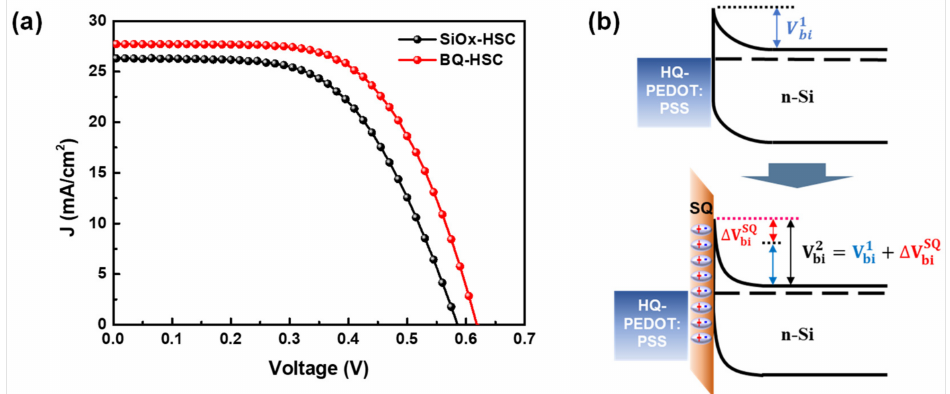
Figure 11. ( a ) Current density vs. voltage curves of SiO x -HSC and BQ-HSC measured under 100 mW/cm 2 illumination (AM1.5) and ( b ) effect of interface dipole formation with BQ passivation of the Si surface. Table 3. Photovoltaic parameters of SiO x -HSC and BQ-HCS. J sc Passivation (mA/cm 2 )